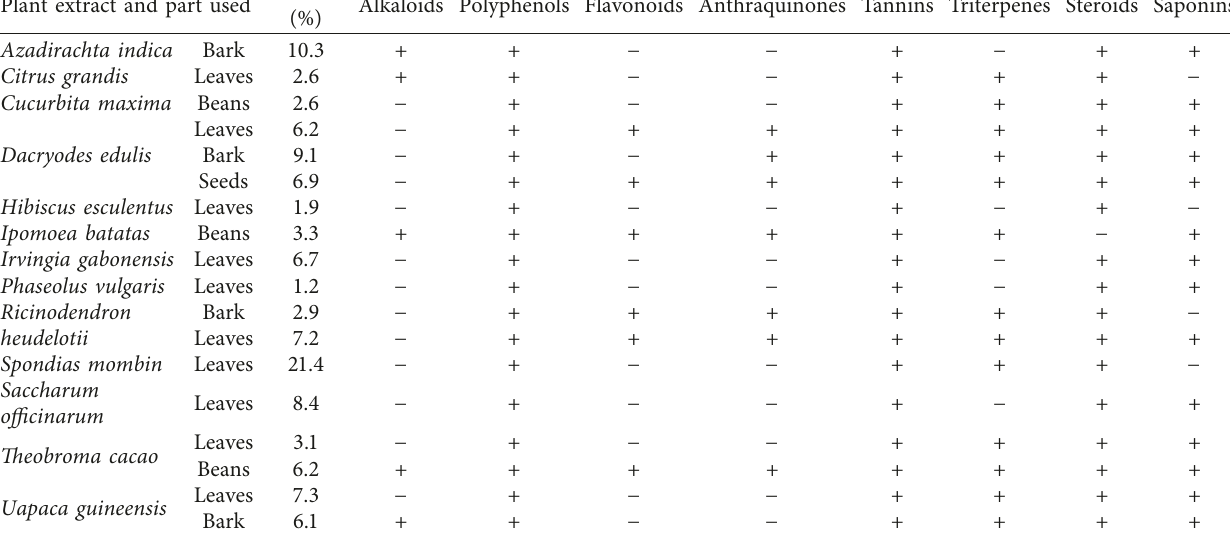
Table 3: Extraction yields and phytochemical composition of the plant extracts. Plant extract and part